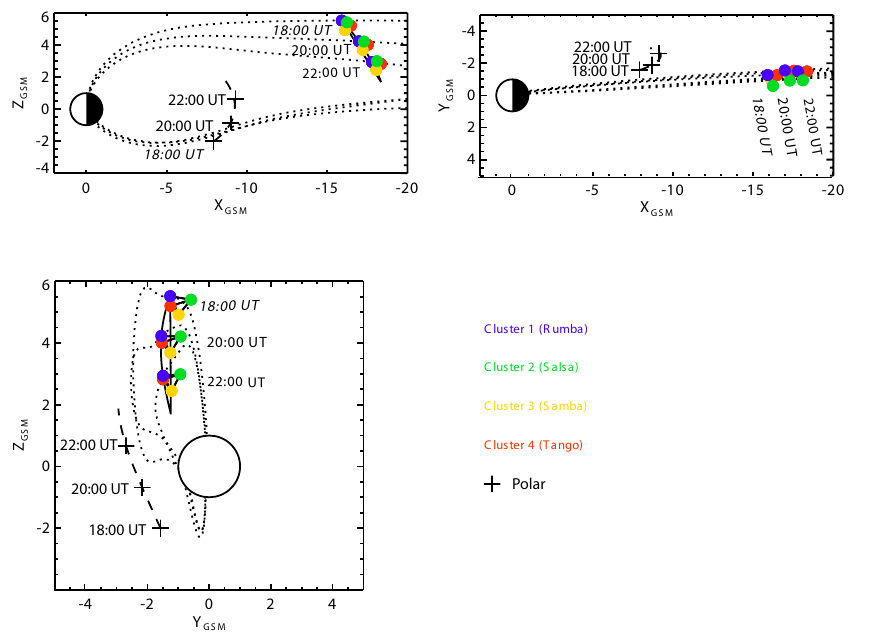
Fig. 2. Orientation of the four Cluster spacecraft and the Polar spacecraft during the 1 September 2002 interval (18:00 to 24:00 UT) in geocentric solar magnetospheric (GSM) coordinates in the xz , xy and yz planes. Blue represents Cluster 1 (Rumba), green Cluster 2 (Salsa), yellow Cluster 3 (Samba) red Cluster 4 (Tango) and a black cross represents the Polar spacecraft. Solid lines show the Cluster spacecraft paths and dashed lines show the Polar spacecraft’s path. Dotted lines depict the model magnetic field.